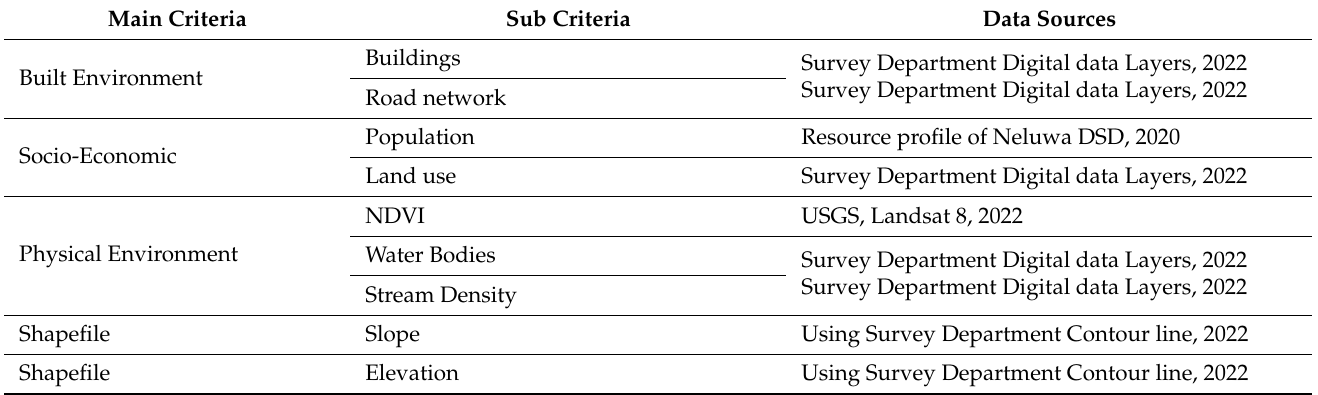
Table 1. Vulnerability criteria used in the